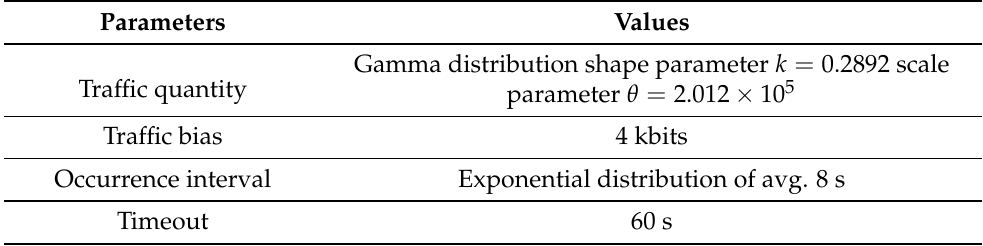
Table 3. The parameters for the traffic